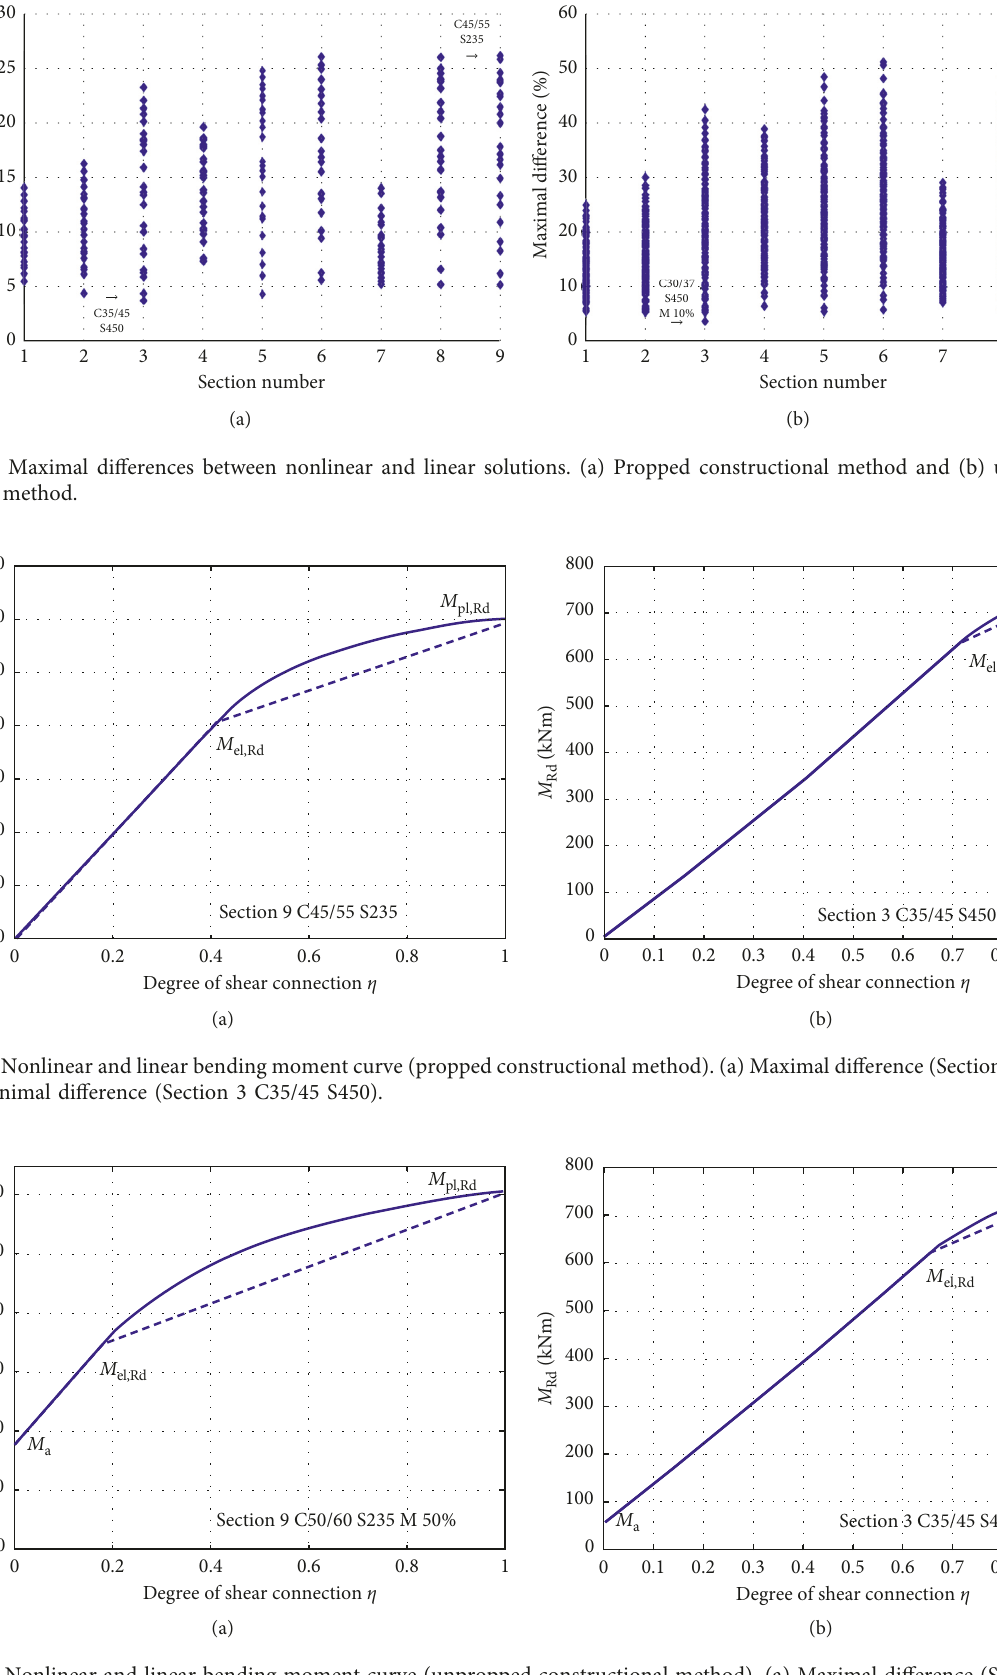
Figure 12: Nonlinear and linear bending moment curve (unpropped constructional method). (a) Maximal difference (Section 9 C50/60 S235 M � 50%) and (b) minimal difference (Section 3 C35/45 S450 M �